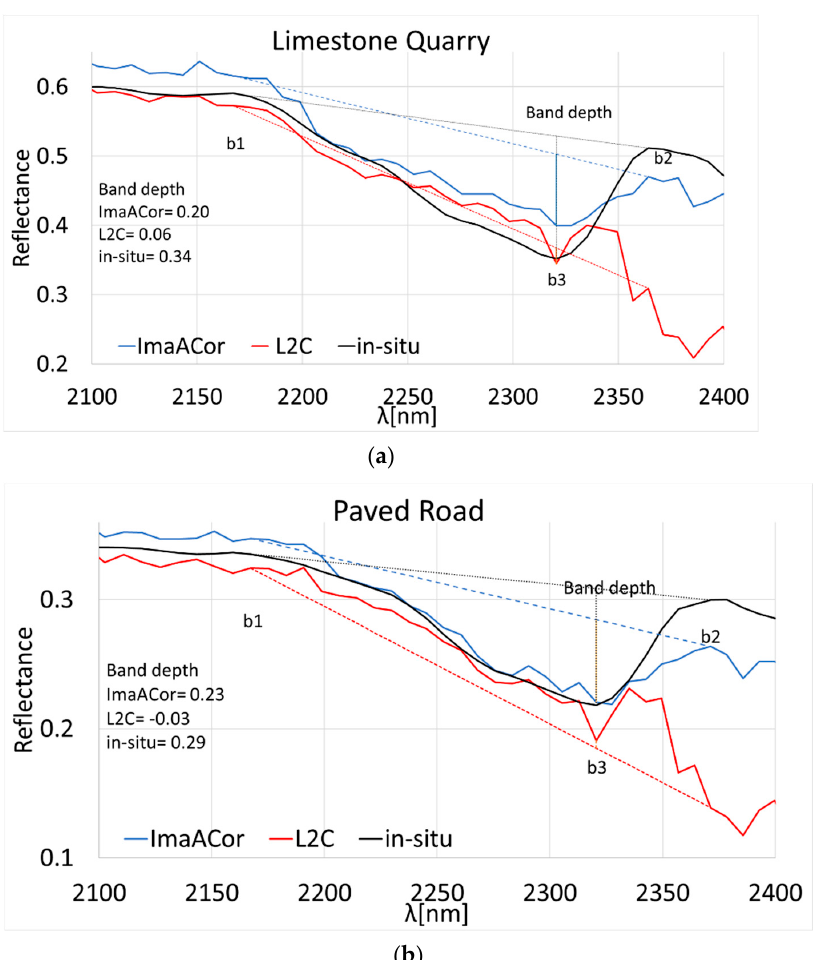
Figure 11. Detail of the L2C, ImaACor, and in situ reflectance spectra of the ( a ) limestone quarry and ( b ) paved square targets, highlighting the spectral feature characteristic of calcareous covers, with the relative band-depth values.